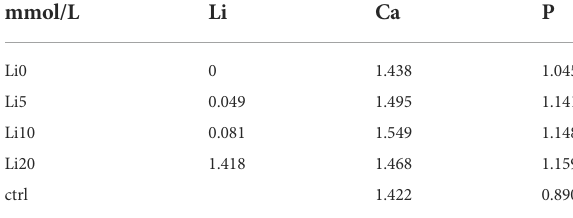
TABLE 2 The ion concentration in supernatant after the Li-BCP powderswithdifferentlithiumcontentssoakedina-MEMsolution for 1 day (control: